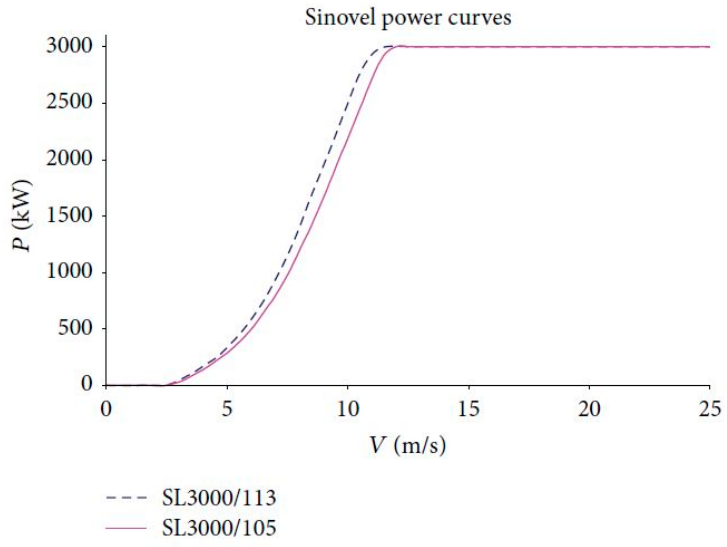
Figure 10. Power curve of the offshore wind turbine Sinovel SL3000-113 *. Source: [59]. * Citation of commercial trademarks and models does not mean recommendation by the authors.